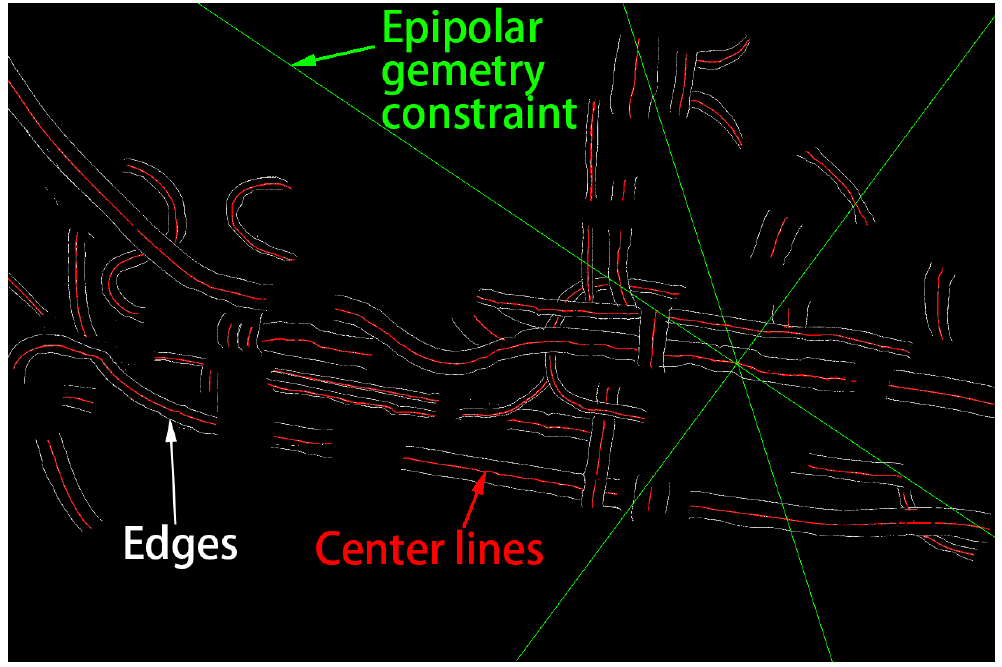
Figure 7. Epipolar geometry constrains in one image.